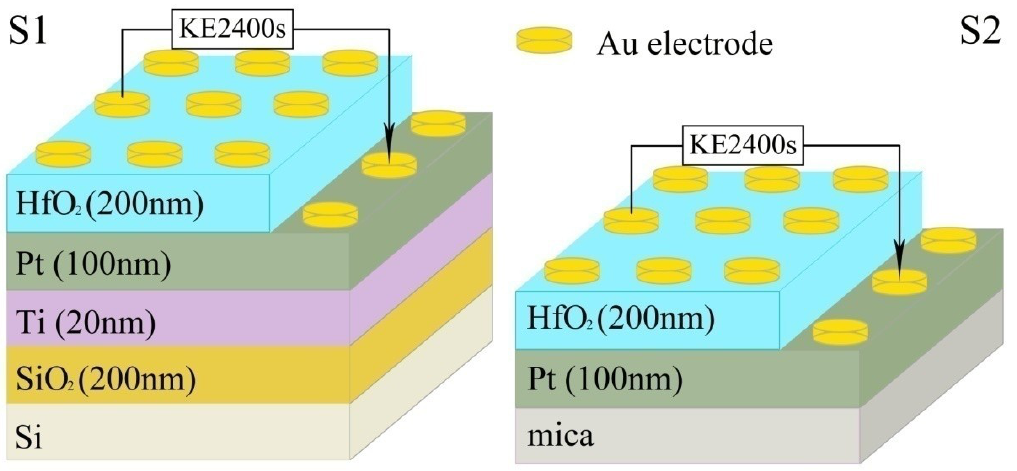
Figure 1. Schematic patterns of the HfO 2 /Pt/Ti/SiO 2 /Si (S1) and HfO 2 /Pt/mica (S2) devices.